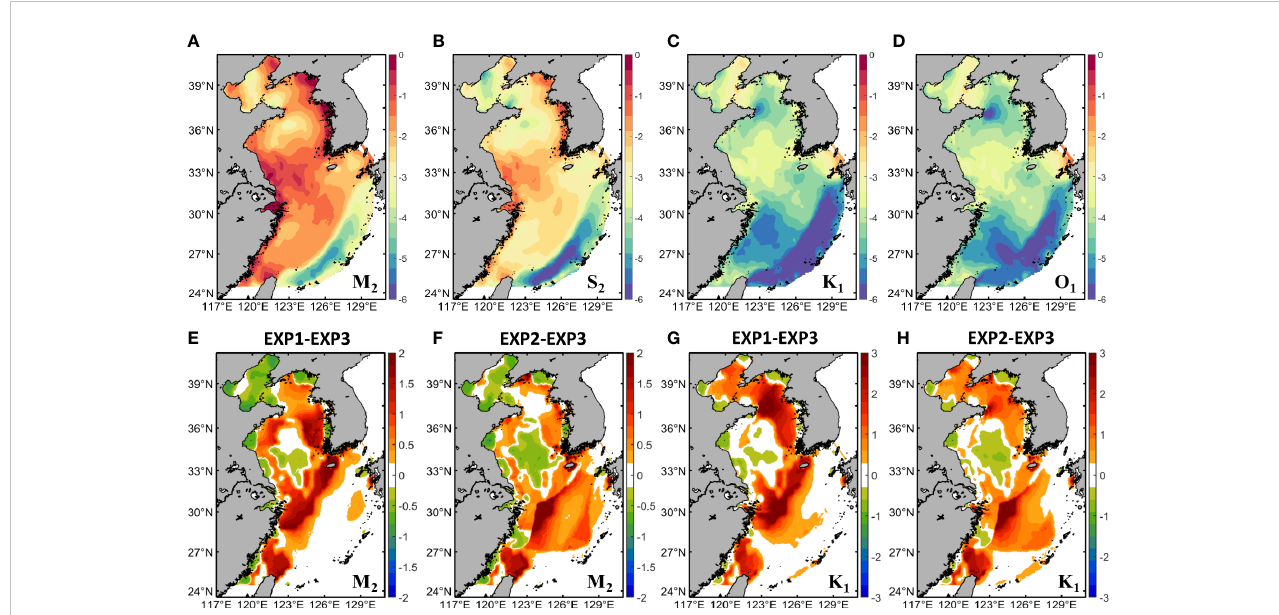
FIGURE 9 (A – D) Estimations of bottom friction dissipation for M 2 , S 2 , K 1 , and O 1 tides in EXP 3 on a log scale, respectively ( log 10 D , unit: log 10 ( W / m 2 )). (E – H) Relative differences of semidiurnal and diurnal bottom friction dissipation between EXP 1, EXP 2 to EXP 3,